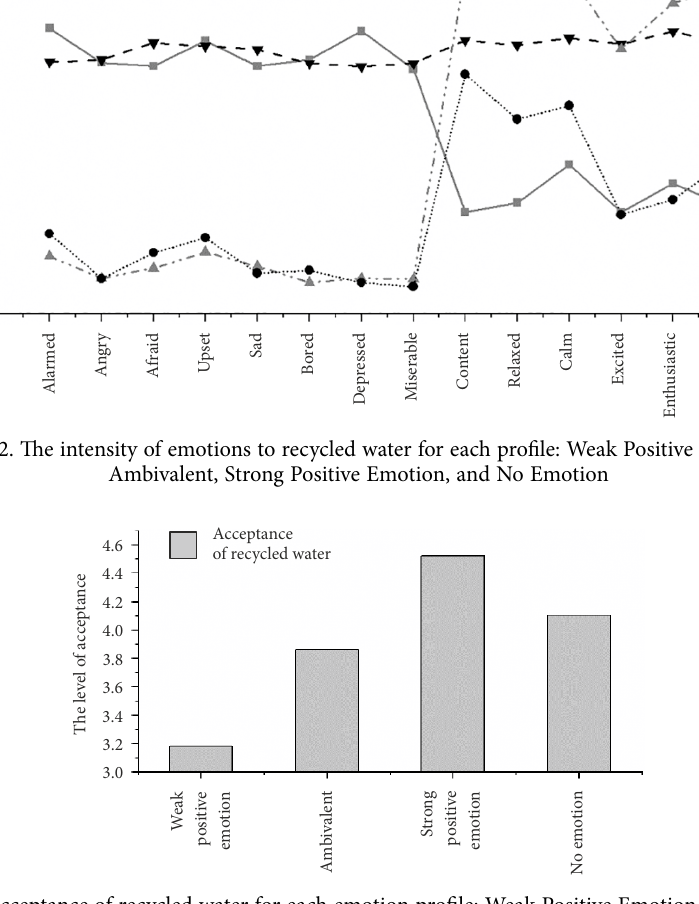
Figure 3. Acceptance of recycled water for each emotion profile: Weak Positive Emotion, Ambivalent, Strong Positive Emotion, and No Emotion